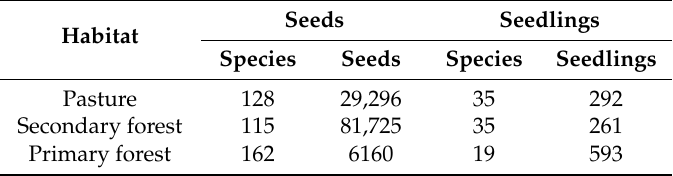
Table 1. Total number of species and individuals found as seeds and seedlings from 2007 to 2008 in each of three habitats in a tropical agricultural landscape of Los Tuxtlas,